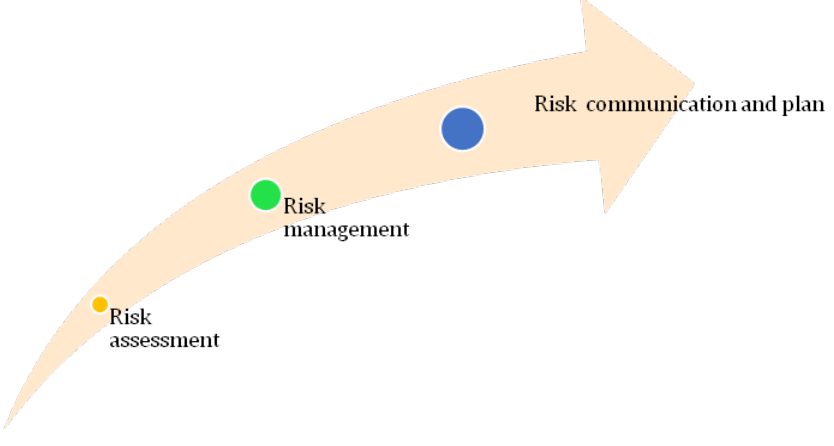
Figure 3. Risk aspects of green nanotechnology.